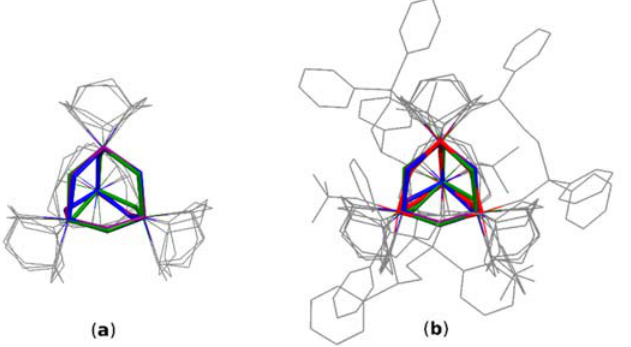
Figure 5. ( a ) The overlay of the [Fe 4 O 6 ] cores of selected structures from CSD ( b ) The overlay of [Fe 4 O 6 ] cores of selected structures from CSD and structure I . Only compared cores are colored and hydrogens are omitted for clarity. I —red, EYAVIJ—purple, JAZZUF—blue, YAXZON—green.